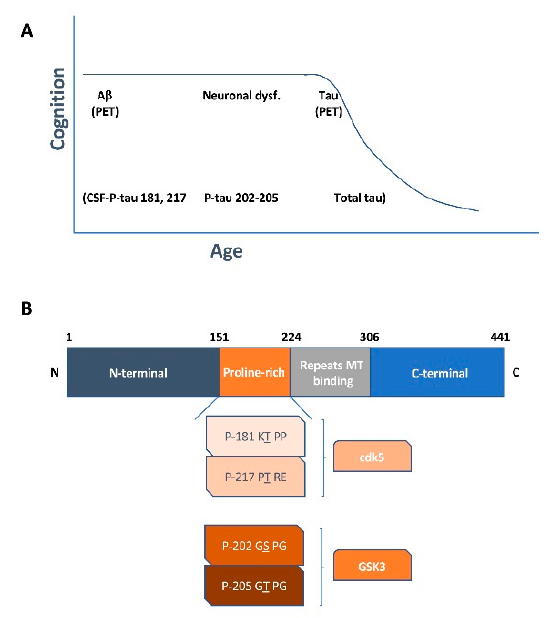
Figure 1. Phosphotau as the AD marker. ( A ) The diagram shows several markers for AD progression. Phosphorylation at several tau epitopes can be used as a marker for AD. At the very early stage, phosphotau 181 and 217 could be found in cerebrospinal fluid (CSF). At that stage, the level of amyloid is increased, and it can be already identified by PET analysis. At later stages, amyloid level increases and it could bind to other cell receptors, involving alternative signaling pathways and activation of other kinase like GSK3. ( B ) Schematic diagram of the Tau protein showing phosphorylation at residues, modified by GSK3 and cdk5, at the proline rich region of the